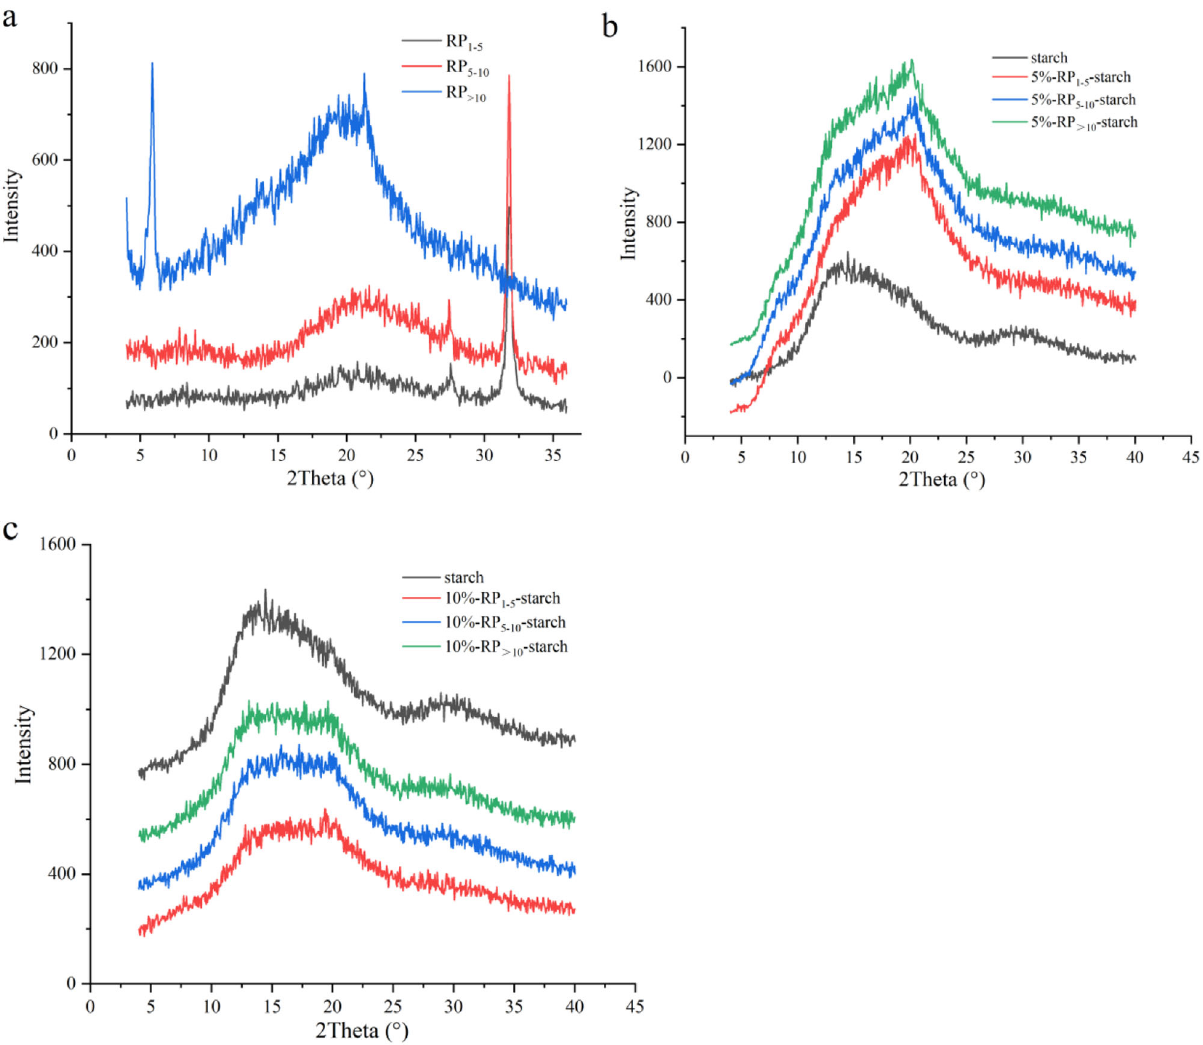
Fig. 2 X-ray diffraction patterns of RP, 5% RP-starch complexes, and 10% RP-starch complexes. a X-ray diffraction patterns of rice peptides with different molecular weights (1 – 5, 5 – 10, and >10 kDa). b X-ray diffraction patterns of 5% RP-starch complexes. c X-ray diffraction patterns of 10% RP-starch complexes. Table 3. The XRD, FTIR spectra, and SAXS analysis parameters of RP- starch complexes. Addition